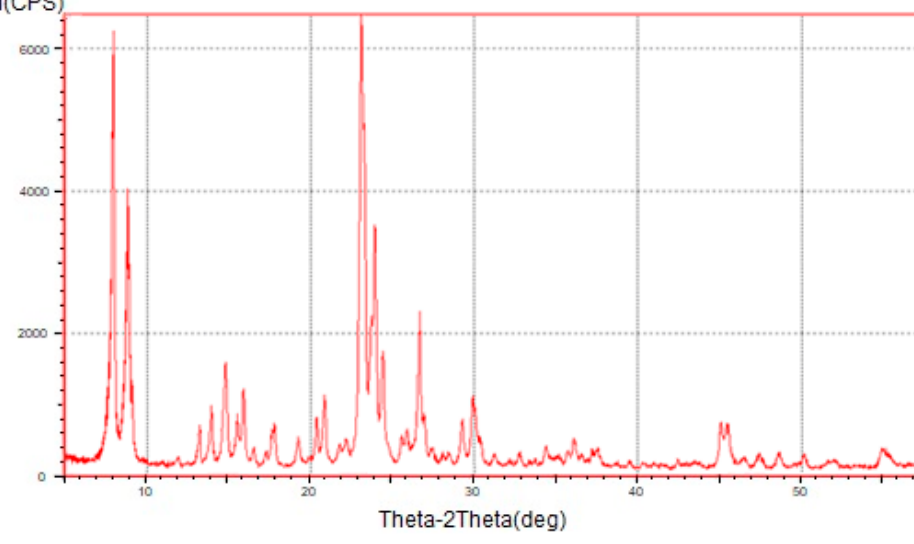
Figure 1. X-ray spectrum of H-ZKE-AF zeolite Figure 1. X ‐ ray spectrum of H ‐ ZKE ‐ AF zeolite catalyst.